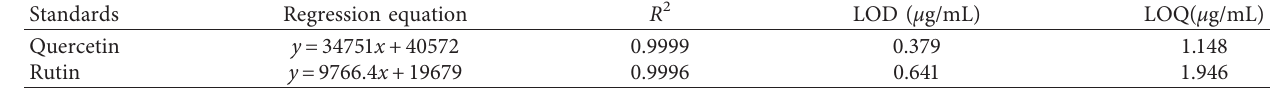
Table 4: Regression data, LODs, and LOQs for quercetin and rutin analyzed by HPLC.